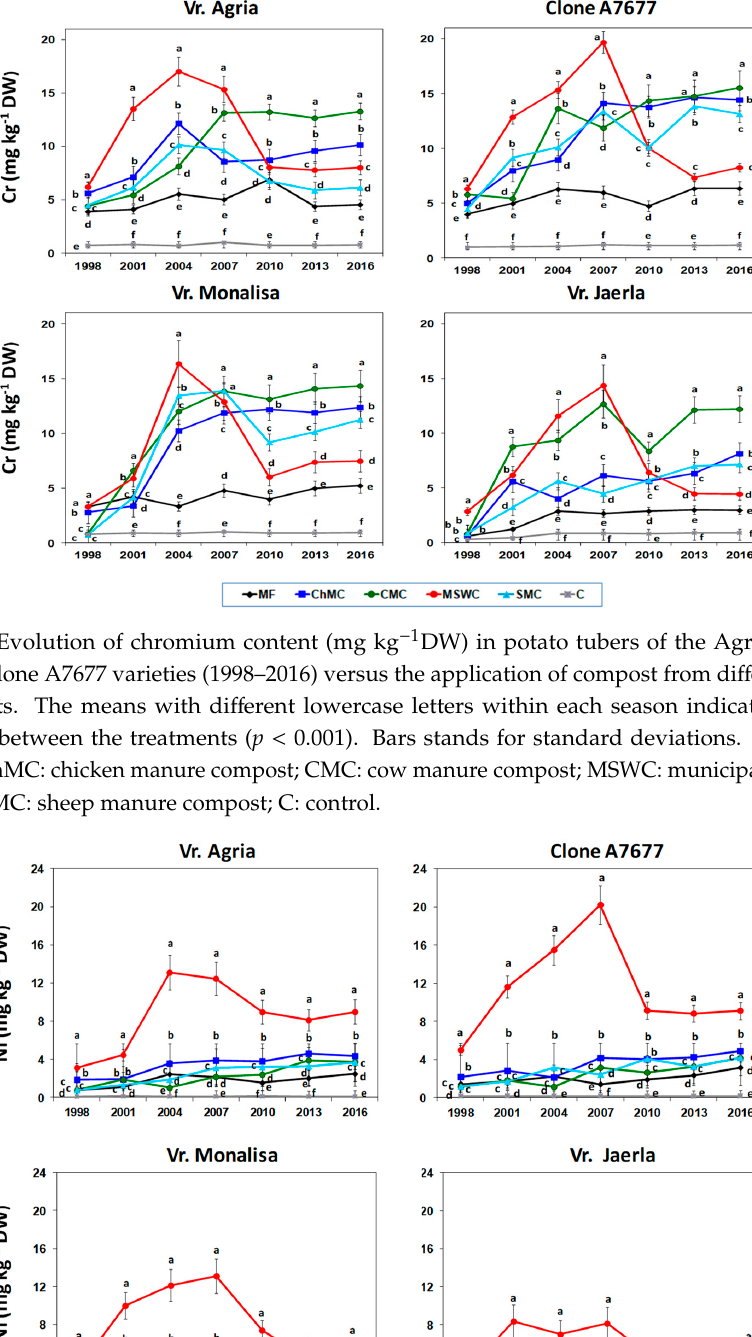
Figure 11. Evolution of lead content (mg kg − 1 DW) in potato tubers of the Agria, Monalisa, Jaerla and clone A7677 varieties (1998–2016) versus the application of compost from different organic amendments. The means with different lowercase letters within each season indicate significant differences between the treatments ( p < 0.001). Bars stands for standard deviations. MF: mineral fertilizer; ChMC: chicken manure compost; CMC: cow manure compost; MSWC: municipal solid waste compost; SMC: sheep manure compost; C: control.